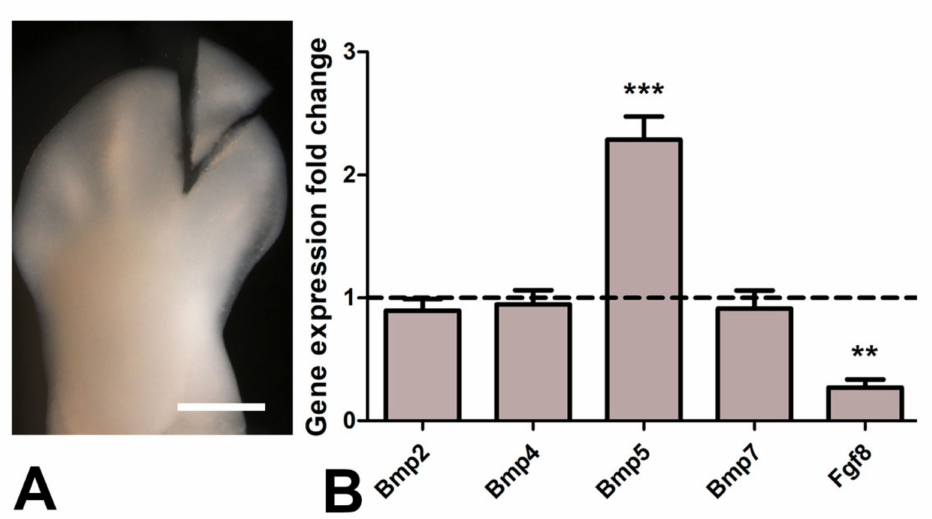
Figure 6. ( A ), representative image of the autopod after microsurgery to dissect free the interdig- ital tissues employed for qPCR analysis and immunocytochemistry. Magnification bar = 300 µ m. ( B ) qPCR comparative analysis of interdigital expressed Bmp genes ( Bmp2 , Bmp4 , Bmp5 , Bmp7 ) and Fgf8 in control interdigits and in experimental interdigits 7 h after the implantation of a TSA bead. The dotted line represents the expression level of each gene in the control samples. Note upregulation of Bmp5 and intense downregulation of Fgf8 in the treated interdigits. ** p < 0.01; *** p <